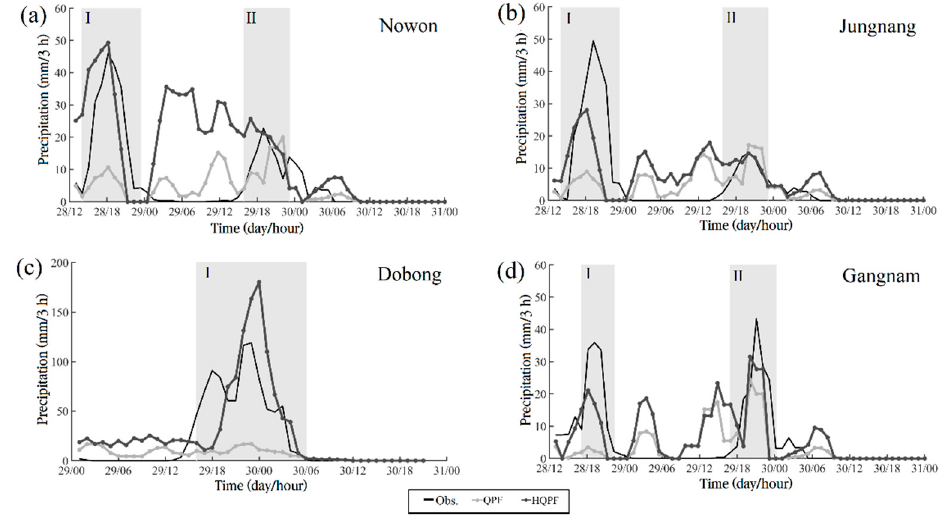
Figure 8. Spatial distribution of percentage error derived from ( a – c ) QPF-based rainfall and ( d – f ) HQPF-based rainfall.